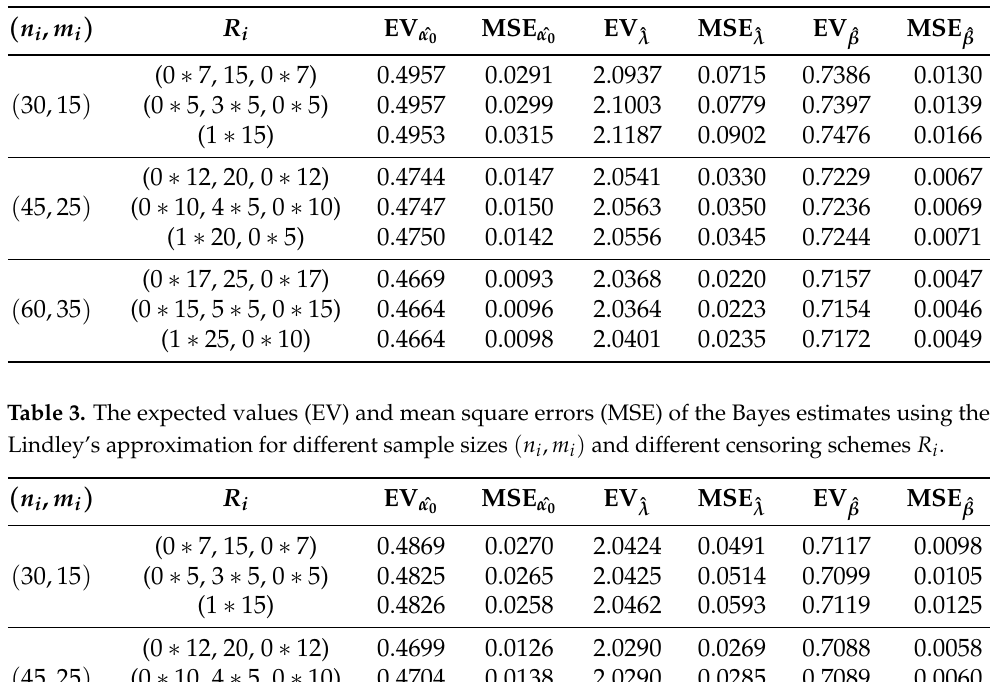
Table 2. The expected values (EV) and mean square errors (MSE) of the Bayes estimates using the Tierney and Kadane technique for different sample sizes ( n i , m i ) and different censoring schemes R i .